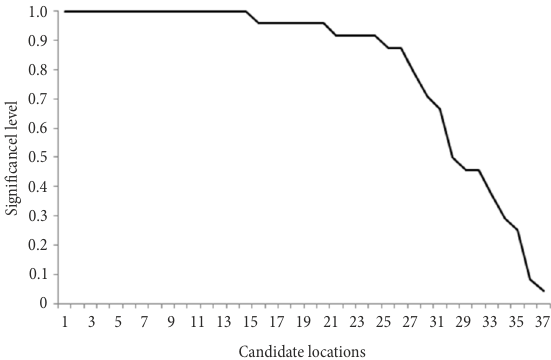
Fig. 7. Frequency of appearance of candidate locations in solutions of the